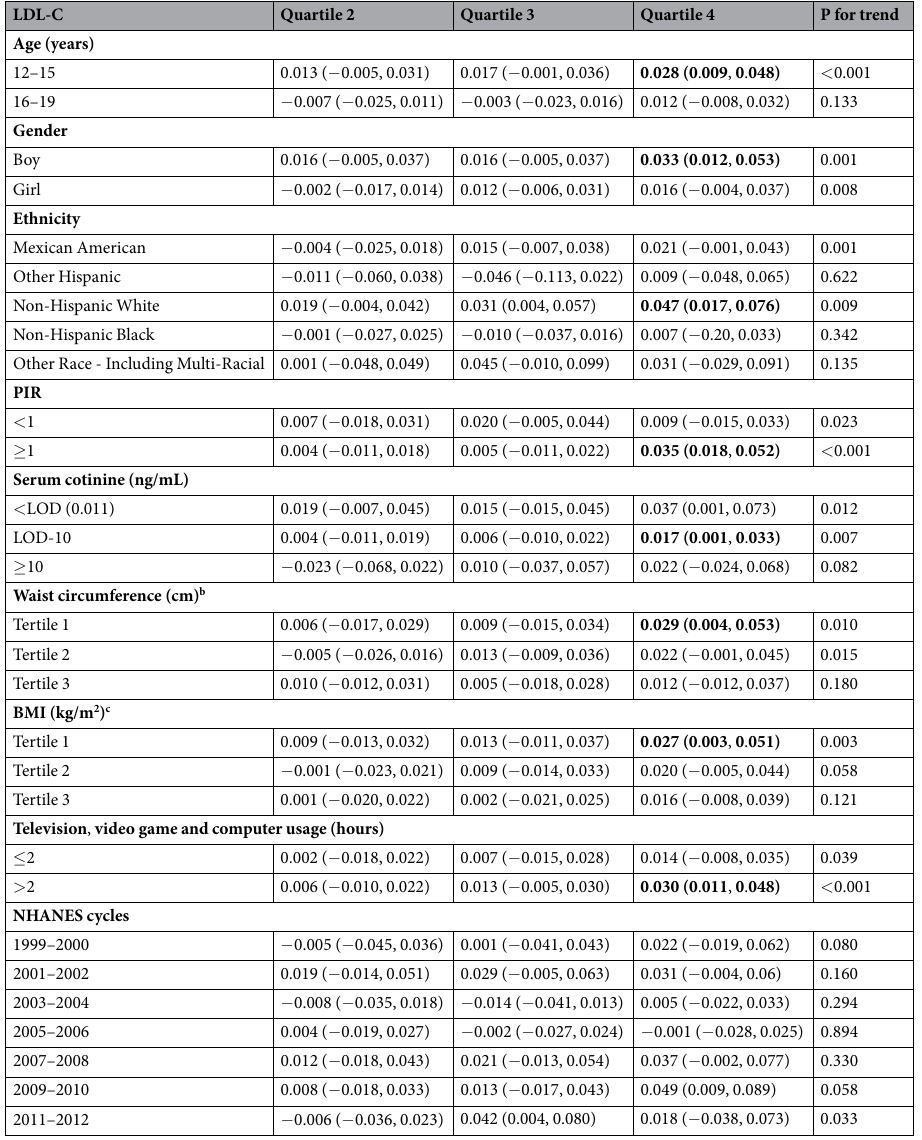
Table 4. Estimated coefficient (beta) and 95% Confidence Intervals (95% CI) in serum low-density lipoprotein cholesterol in US adolescents 1999–2012 for each quartile increase in blood lead levels stratification by different covariates Model was adjusted as age, gender, ethnicity, PIR, waist circumference, serum cotinine, and physical activity. CVD, cardiovascular disease; HDL-C, high-density lipoprotein cholesterol; LDL-C, low-density lipoprotein cholesterol; PIR, poverty index ratio. Lead( μ g/dL), Quartile 1: < 0.6; Quartile 2: 0.6–0.9; Quartile